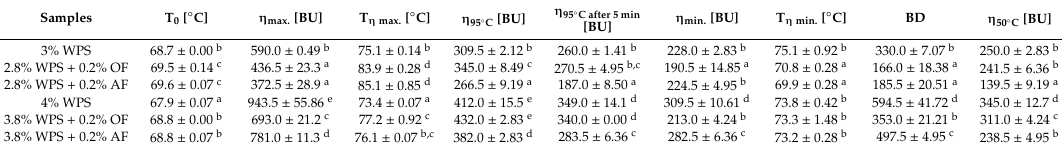
Table 1. Pasting characteristics of waxy potato starch with an addition of oat and apple dietary fibers.